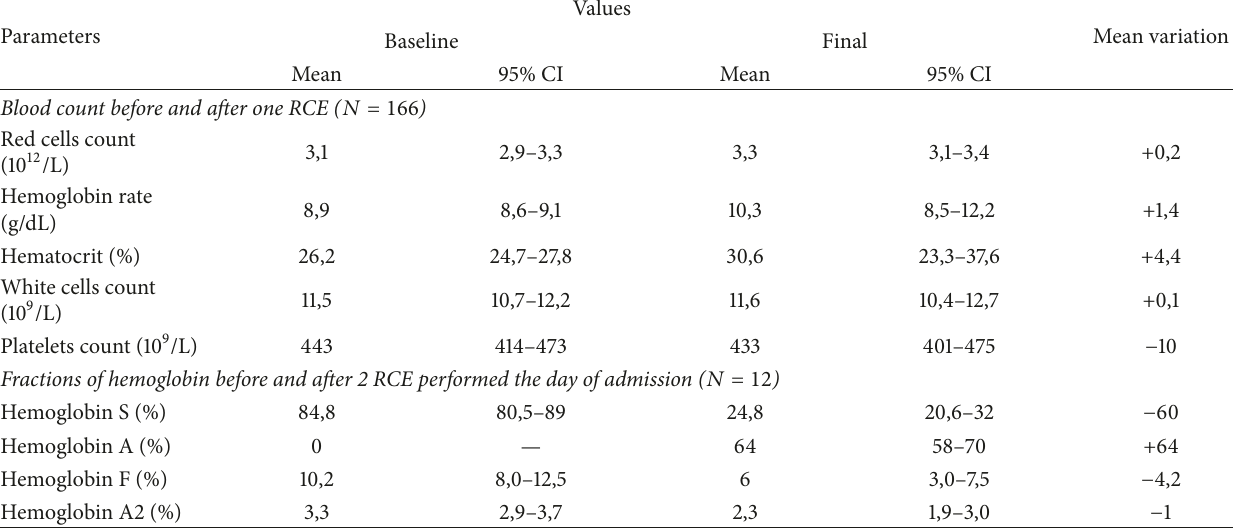
Table 2: Evaluation of the blood count parameters after one RCE and hemoglobin fractions after 2 consecutive RCE performed the day of admission. Parameters